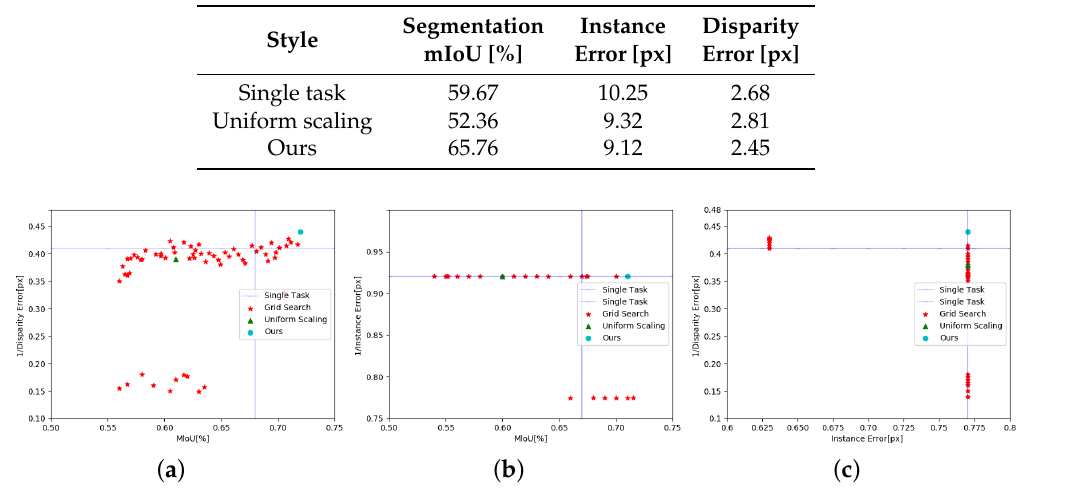
Table 2. Performance of MTS performance in instances segmentation, semantic segmentation, and monocular depth segmentation on Cityscapes.